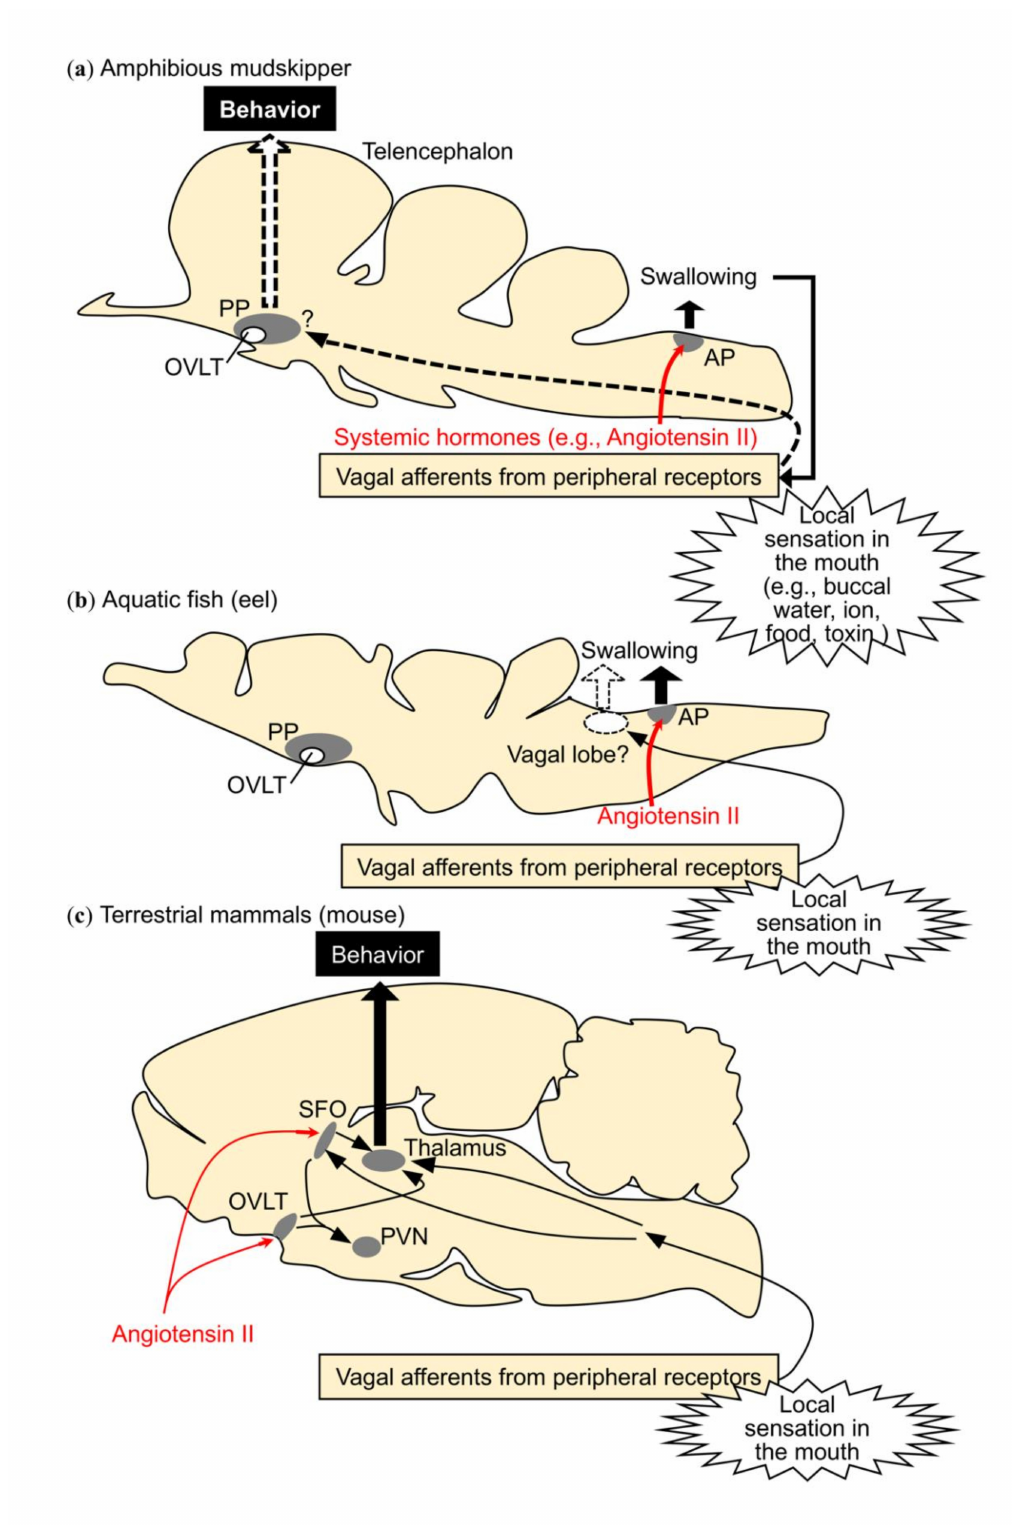
Figure 3. A theoretical model illustrating regulatory mechanisms of drinking behavior in amphibious mudskippers, aquatic fish and terrestrial mammals. The area postrema (AP), organum vasculosum of the lamina terminalis (OVLT) and subfornical organ (SFO) are collectively referred to as the circumventricular organs (CVOs) in the brain. The AP and OVLT have been identified in fish and tetrapods, but the SFO has only been identified in tetrapods. ( a ) Comparatively simple mechanisms